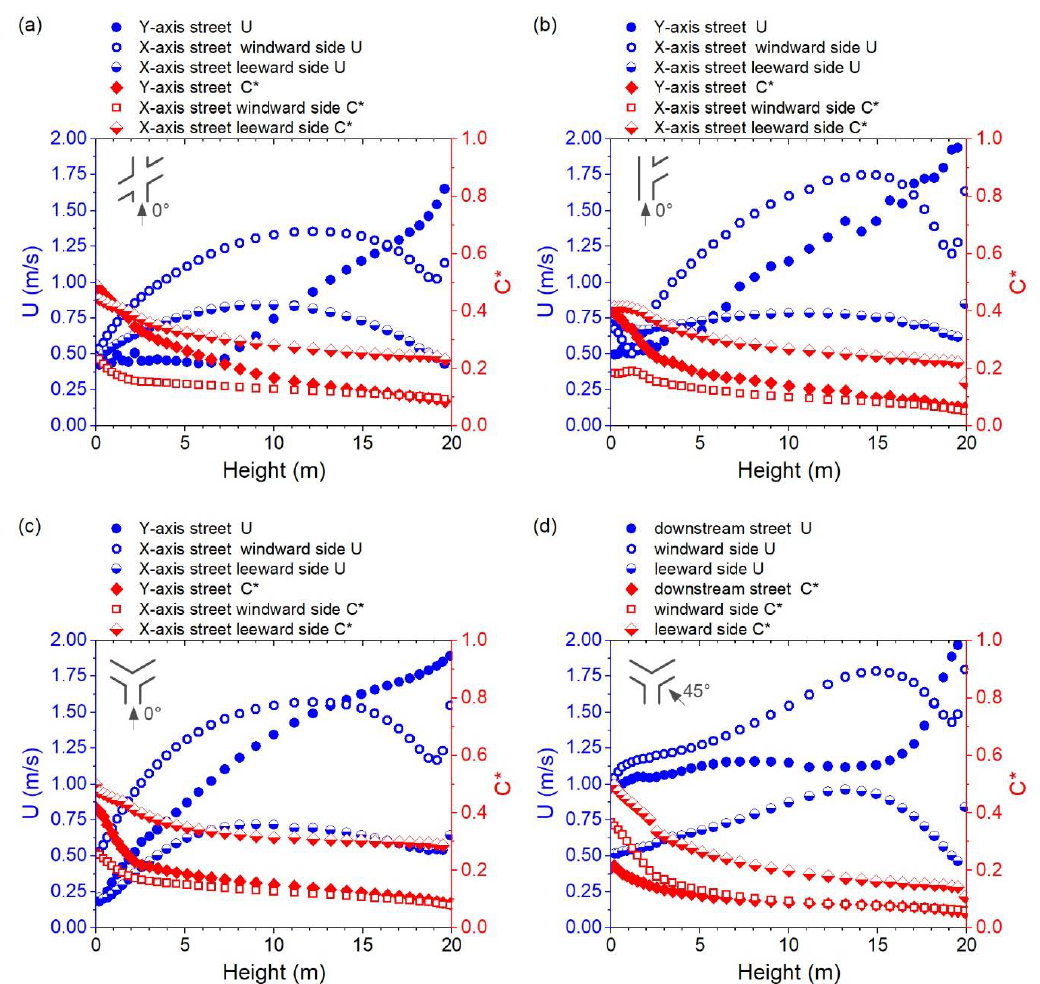
Figure 11. Vertical distribution of wind velocity (U) and normalized pollutant concentration (C*) for the near-wall surfaces in Cases ( a ) C-0, ( b ) F-0, ( c ) E-0, and ( d ) E-45.